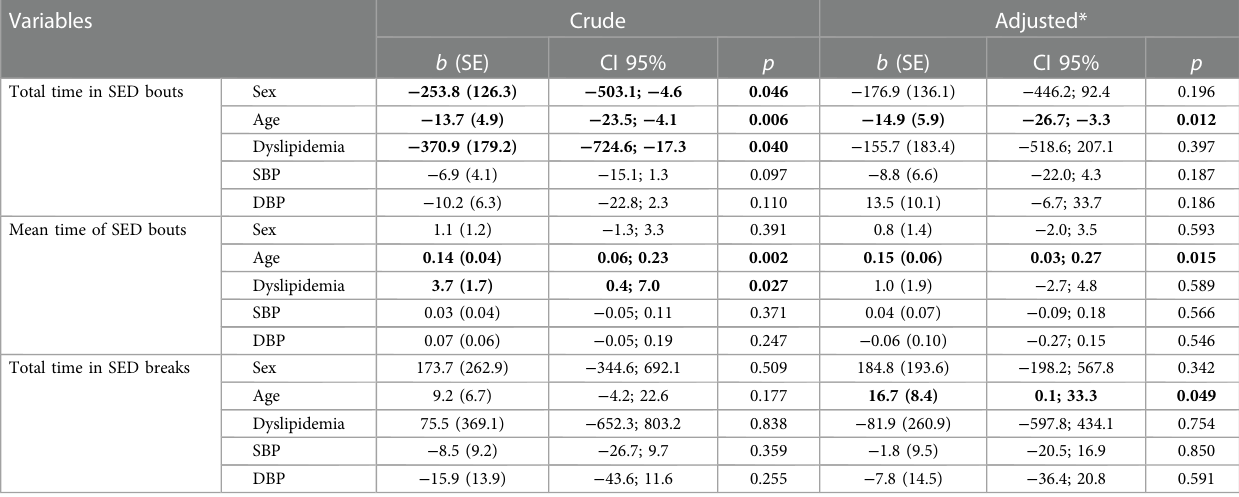
TABLE 2 Crude and adjusted regression of the total time in sedentary bouts, the mean time of sedentary bouts, and the total time in sedentary breaks. Variables